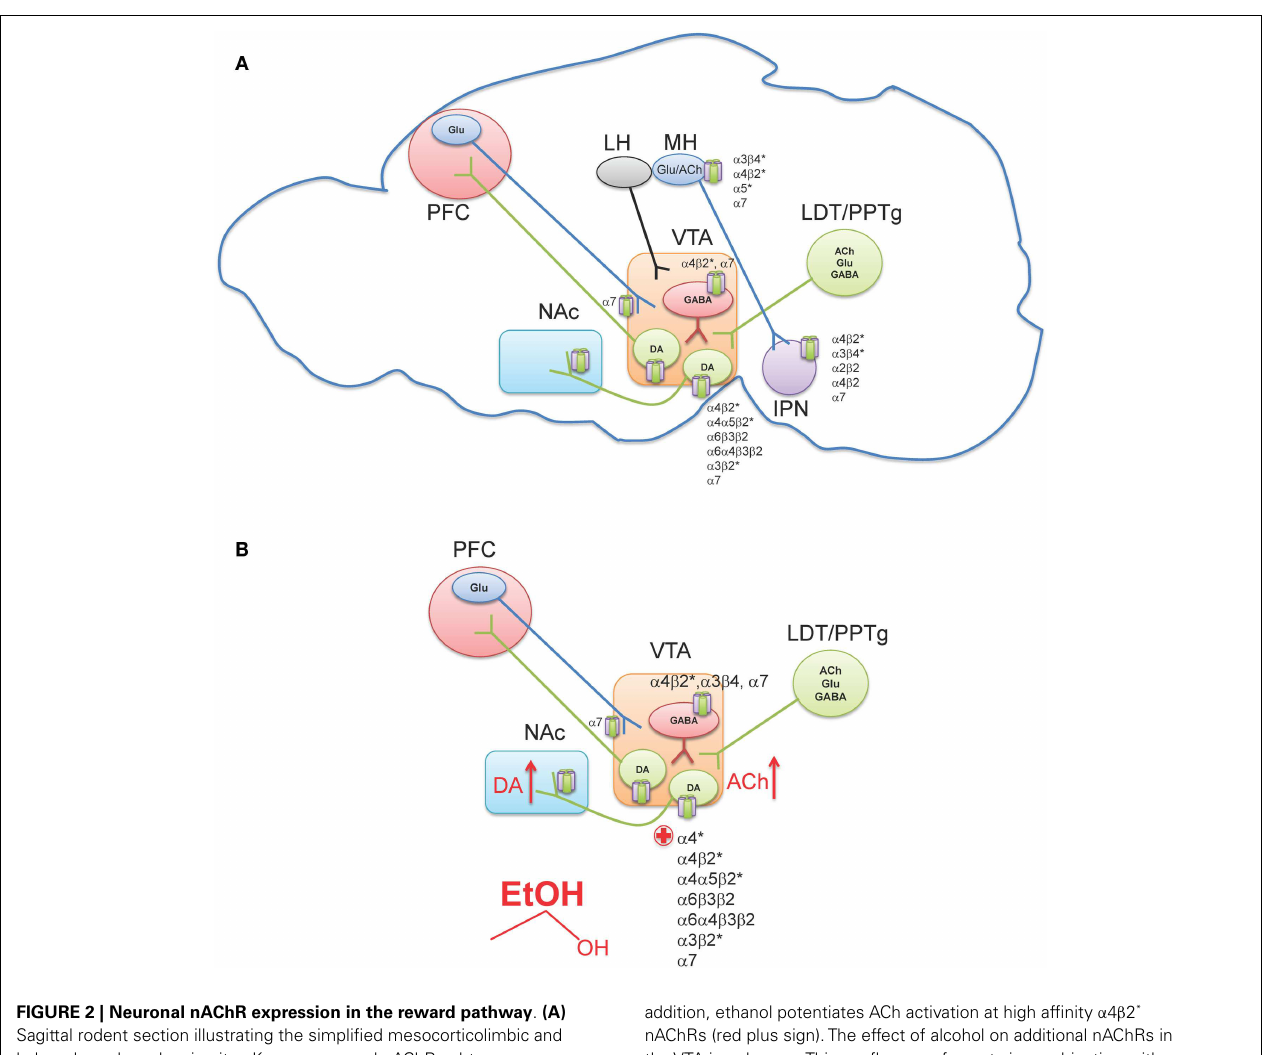
FIGURE 2 | Neuronal nAChR expression in the reward pathway . (A) Sagittal rodent section illustrating the simplified mesocorticolimbic and habenulo-peduncular circuitry. Known neuronal nAChR subtypes expressed in different nuclei are indicated [for a review see (Millar and Gotti, 2009)]. (B) In theVTA, alcohol stimulates DAergic neurons at least, in part, via nAChR activation. Ethanol increases ACh release (red arrow, presumably through cholinergic projection from the LDT/PPTg) which in turn activates nAChRs on DAergic neurons driving activity. In